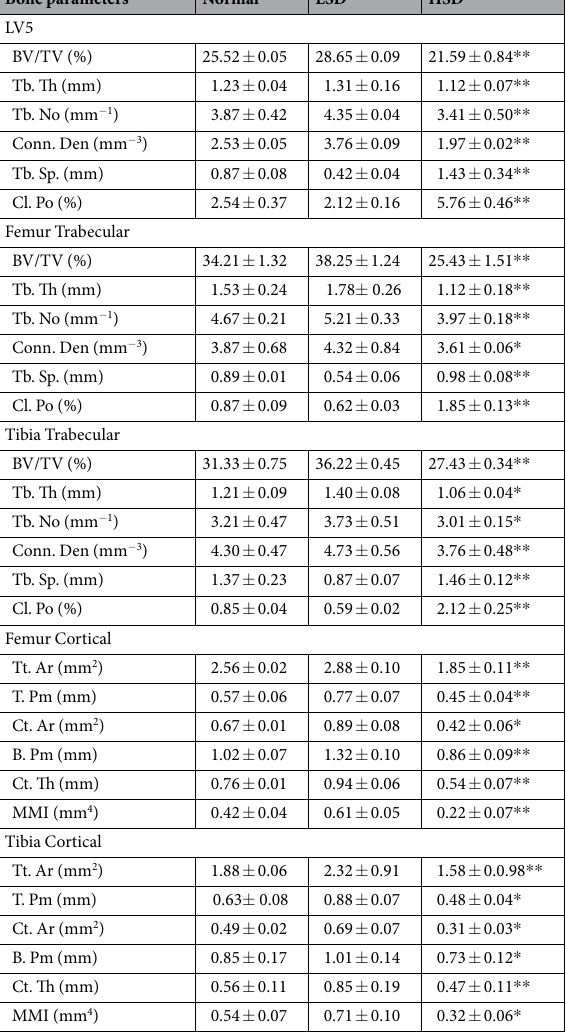
Table 1. Bone histomorphometric parameters of trabecular and cortical bones. High dietary salt intake impairs both trabecular and cortical bone microarchitecture. Histomorphometric parameters of trabecular and cortical bones of LV5, femur and tibia of normal, low salt diet group (LSD) and high salt diet group (HSD). Bone volume/tissue volume ratio (BV/TV); Trabecular thickness (Tb. Th); Trabecular number (Tb. No.); Connectivity density (Conn. Den); Trabecular separation (Tb. Sep.); Trabecular pattern factor (Tb. Pf.); Total cross-sectional area (Tt. Ar.); Total cross-sectional perimeter (T. Pm); Cortical bone area (Ct. Ar); Bone perimeter (B. Pm); Average cortical thickness (Ct. Th); Polar moment of inertia (MMI). The results were evaluated by using ANOVA with subsequent comparisons by Student t test for paired or nonpaired data, as appropriate. Inner values are expressed as mean ± SEM (n = 10) and similar results were obtained in